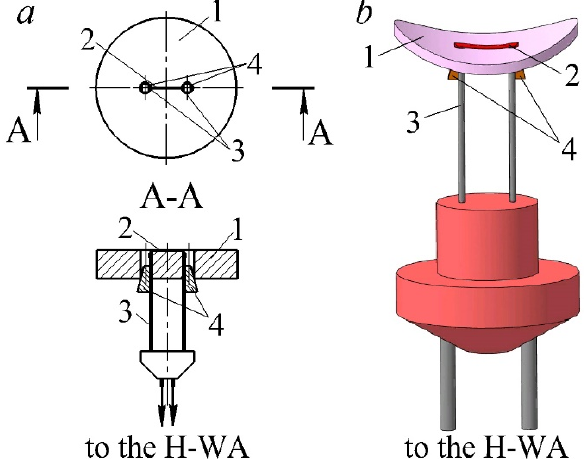
Figure 1. Scheme ( a ) and three-dimensional model ( b ) of the hot-wire anemometer sensor: 1—fluor- oplastic substrate (thermal conductivity—0.07 W/(m·K)); 2—sensitive element of the sensor (a ni- 1—fluoroplastic substrate (thermal conductivity—0.07 W/(m · K)); 2—sensitive element of the sen- chrome thread with a diameter of 5 μ m and a length of 3–5 mm); 3—conductive rods; 4—wedges sor (a nichrome thread with a diameter of 5 µ m and a length of 3–5 mm); 3—conductive rods; (wood). 4—wedges